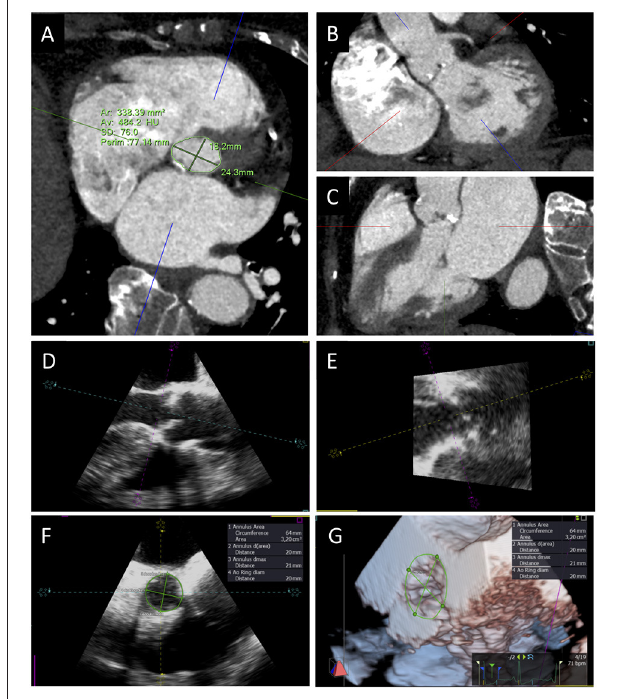
FIGURE 3 | Aortic annulus sizing with CT and 3D TEE. Transverse CT plane aligned at the lowest insertion points of aortic leaflets (A) and orthogonal planes oriented along the main axis of LVOT in short (B) and long axis (C) views. TEE long-axis mid-esophageal view (D) , view of the aortic